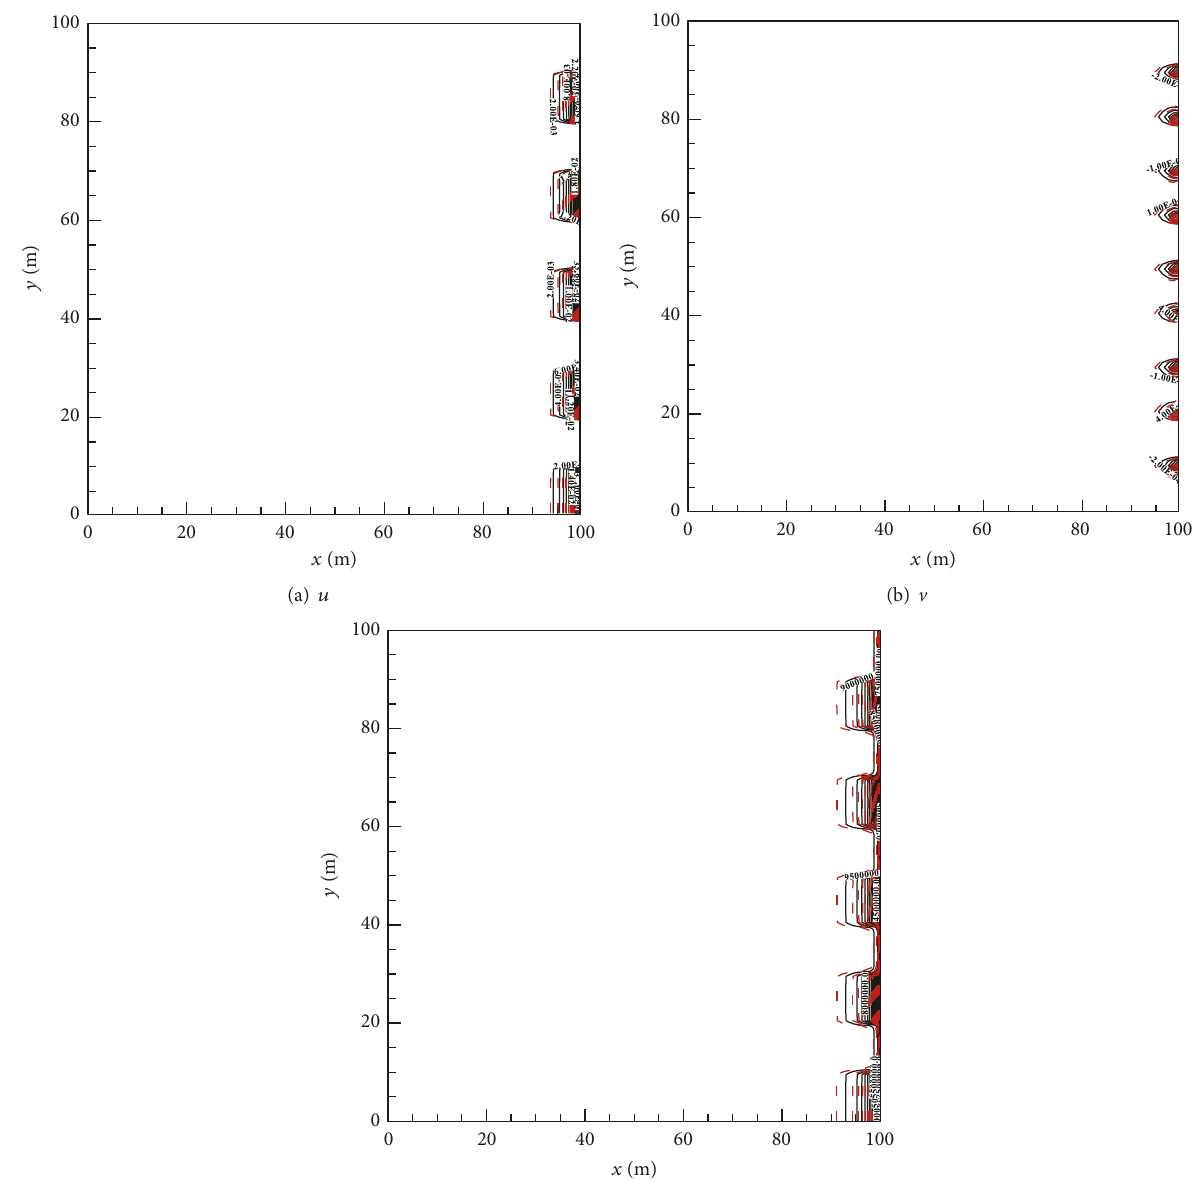
Figure 11: Flow field comparison at the minimum deviation for real gas. Black line: FDM; red dashed line: POD.